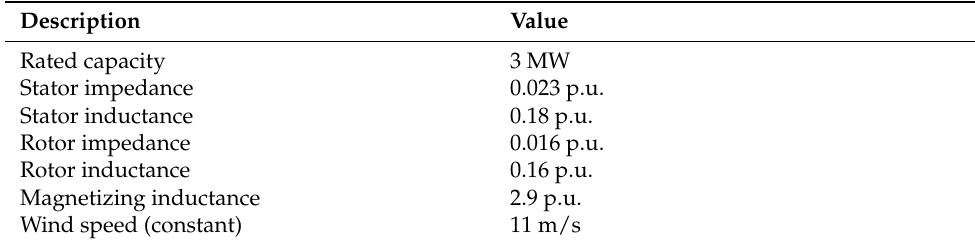
Table 3. Parameters of DFIG.